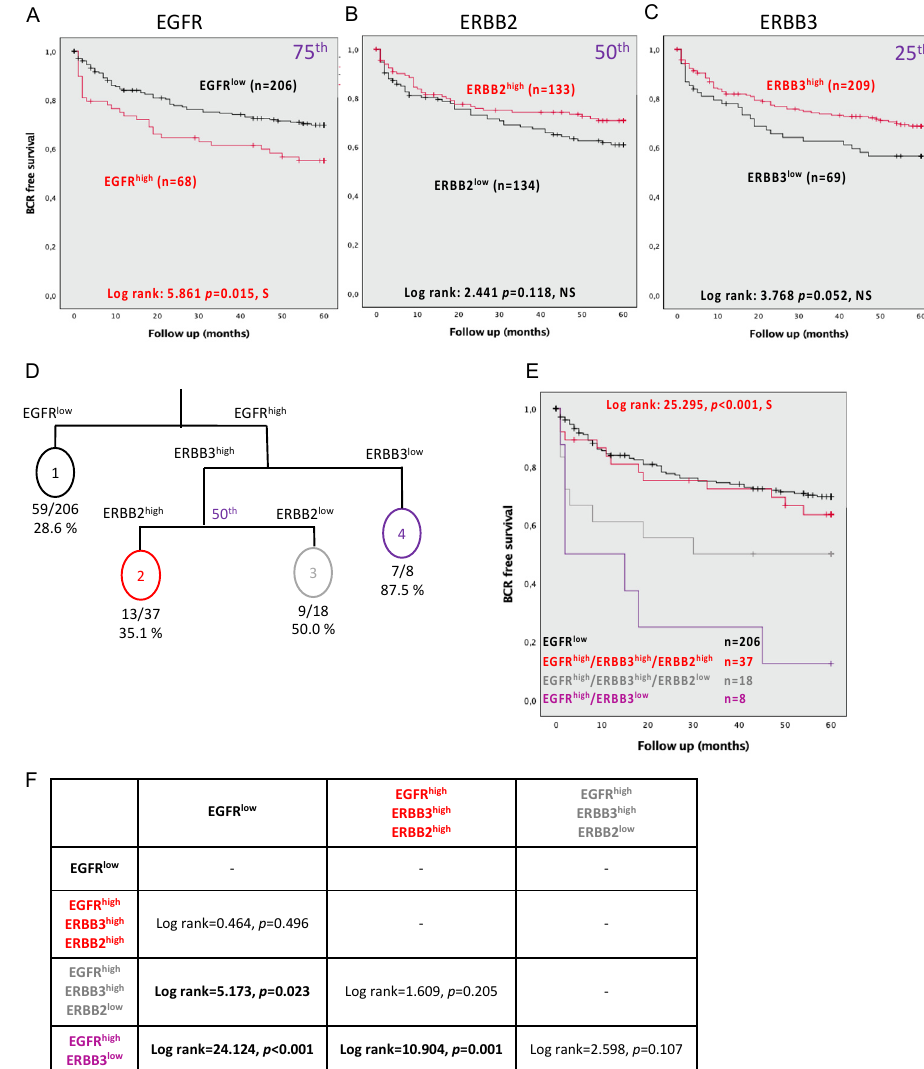
Figure 2. Association of proteins expression in epithelial cells of tumor cores with biochemical recurrence evaluated at five years. Kaplan–Meier curves for ( A ) EGFR with a cutoff at the 75th percentile, ( B ) ERBB2 with a cutoff using the median, and ( C ) ERBB3 with a cutoff at the 25th percentile. ( D ) Survival tree, including EGFR, ERBB2, ERBB3, and BCR in an RPART model. ( E ) Kaplan–Meier plot combines EGFR, ERBB2, and ERBB3 expression. ( F ) Summary table of log rank between each of the conditions of expression of ERBB members. Significance is indicated by log-rank test. p < 0.05 was considered significant; NS, not significant; S, significant.